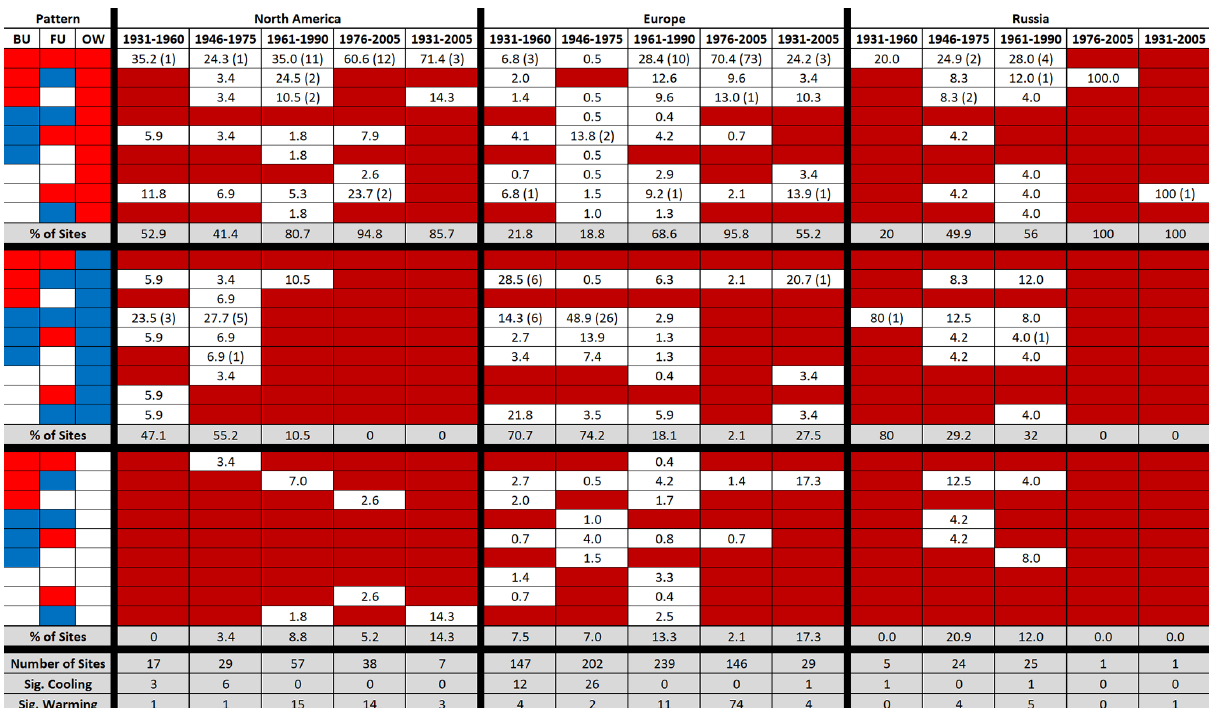
Figure 9. Summary of trends for sites with data for breakup (BU), freeze-up (FU), and open-water-day (OW) trends that were derived from the Mann–Kendall and Sen’s slope analysis. On the left, where the pattern is shown as red the phenomena had a warming trend, as blue they had a cooling trend, and as white they had no trend – thus, the top row shows breakup was earlier, freeze-up later, and the number of open-water days increased. The values in the different columns show the proportion of sites during each time period that experienced the specific trend combination, with the number in brackets being the number of sites with open-water-day trends that were significant (Sig.) – e.g. 23.5% of North American sites from 1931–1960 had a combination of later breakup, earlier freeze-up, and fewer open-water days, all cooling trends, with three of these sites displaying an open-water-day trend that was significant. This allows for the relative contributions of trend directions for breakup and freeze-up changes to be compared against changes in the number of open-water days. The dark red cells show specific combinations of trends during that time period which were not experienced at any